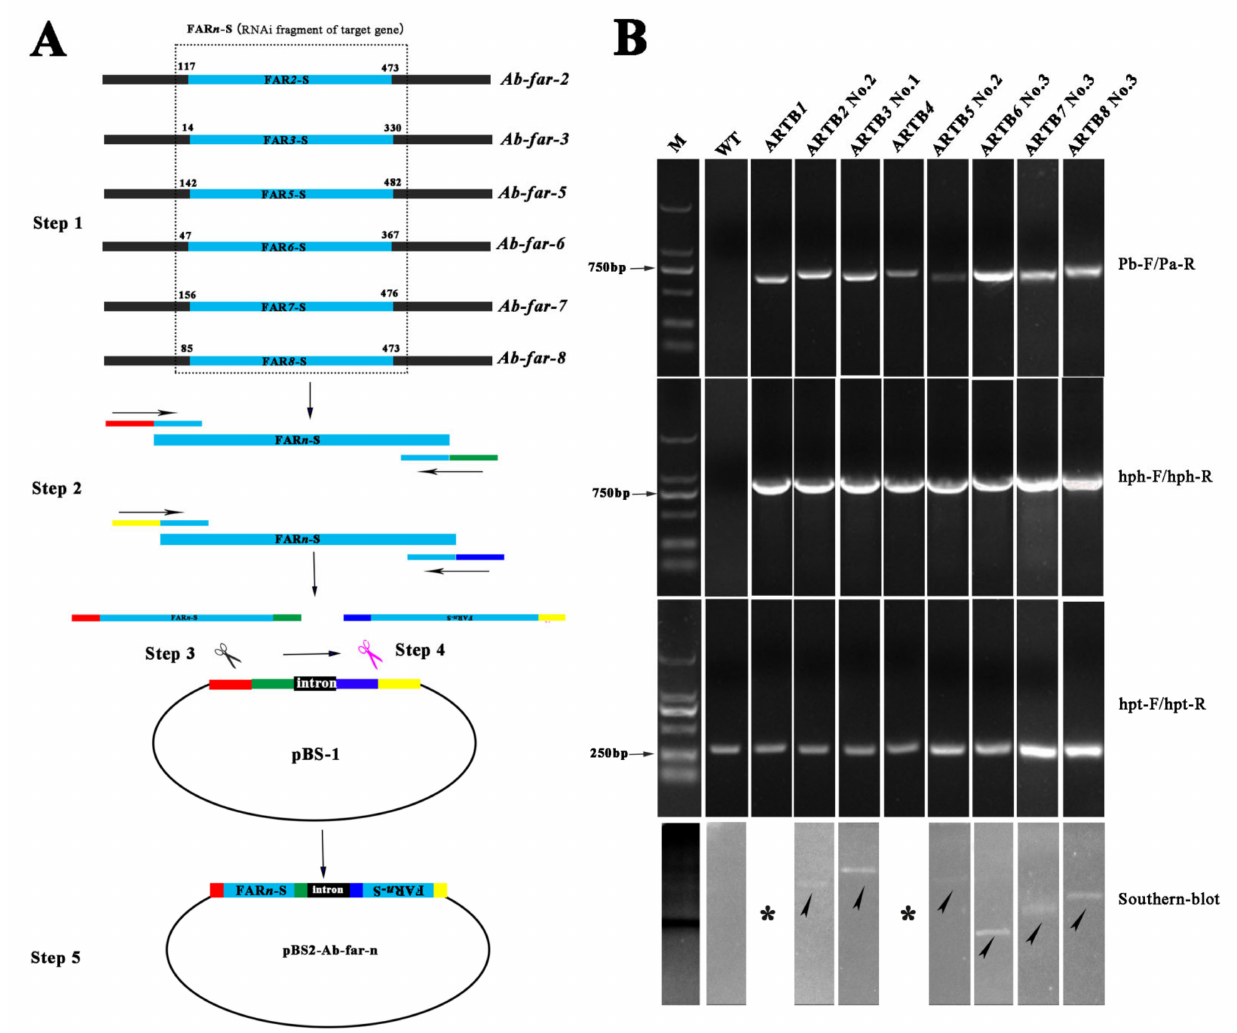
Figure 1. Production and identification of Aphelenchoides besseyi Ab-far-n hpRNA transgenic Botrytis cinerea . ( A ) Schematic of RNAi vector construction. Step 1: Selection of RNAi fragments, Step 2: PCR amplification of RNAi fragments, Step 3: Sense fragment insertion process, Step 4: Antisense fragment insertion process, and Step 5: Generation of final vector pBS2-Ab-far-n. ( B ) PCR identification and Southern blot of Ab-far-n hpRNA transgenic B. cinerea . M, marker DL2000; WT, wild-type B. cinerea ; ARTB1-ARTB8, Ab-far-1 to Ab-far-8 hpRNA transgenic B. cinerea ; No.1- No.3, strain 1–3. * Please refer the citation of the paper Ding et al.